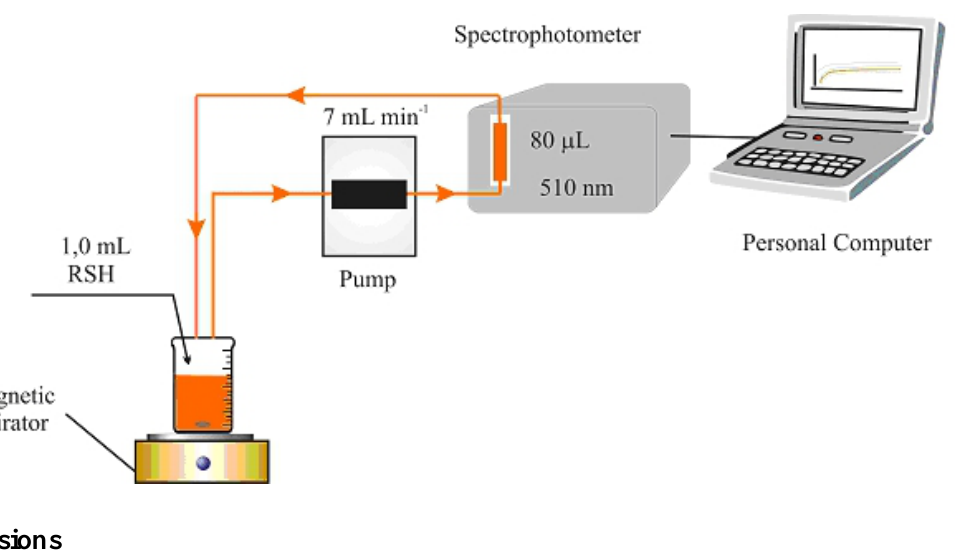
Figure 10 . Flow system with a UV/Vis spectrophotometer as